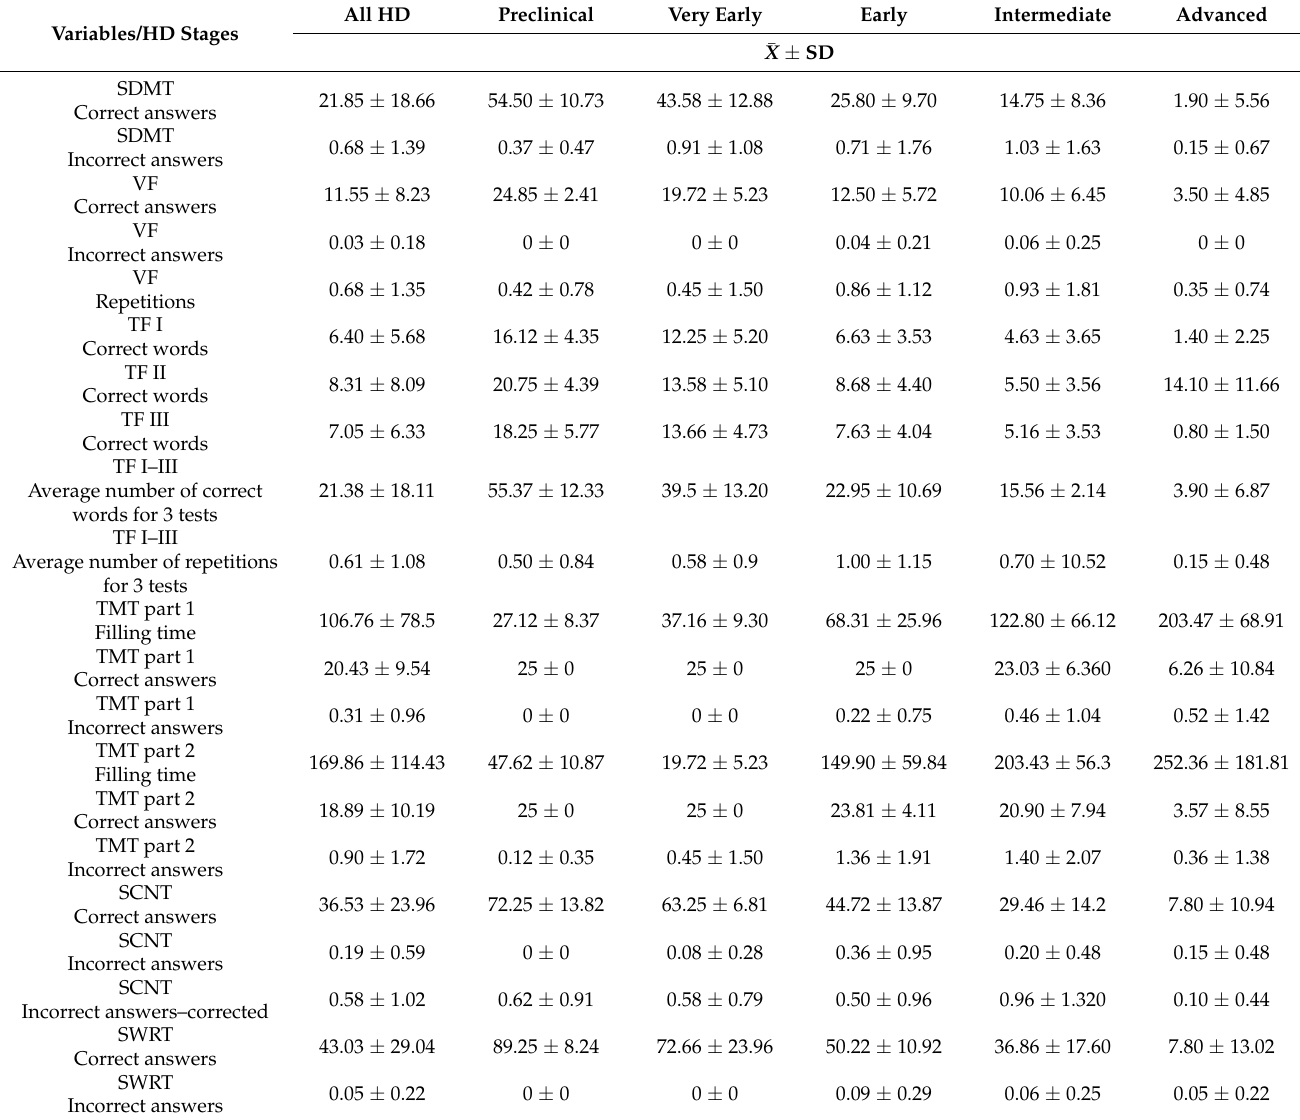
Table 3. Results of neuropsychological assessment depending on the HD